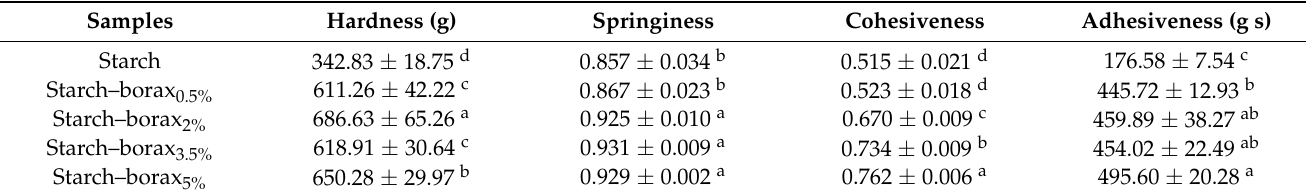
Table 1. Texture properties of normal starch hydrogels and starch–borax DC